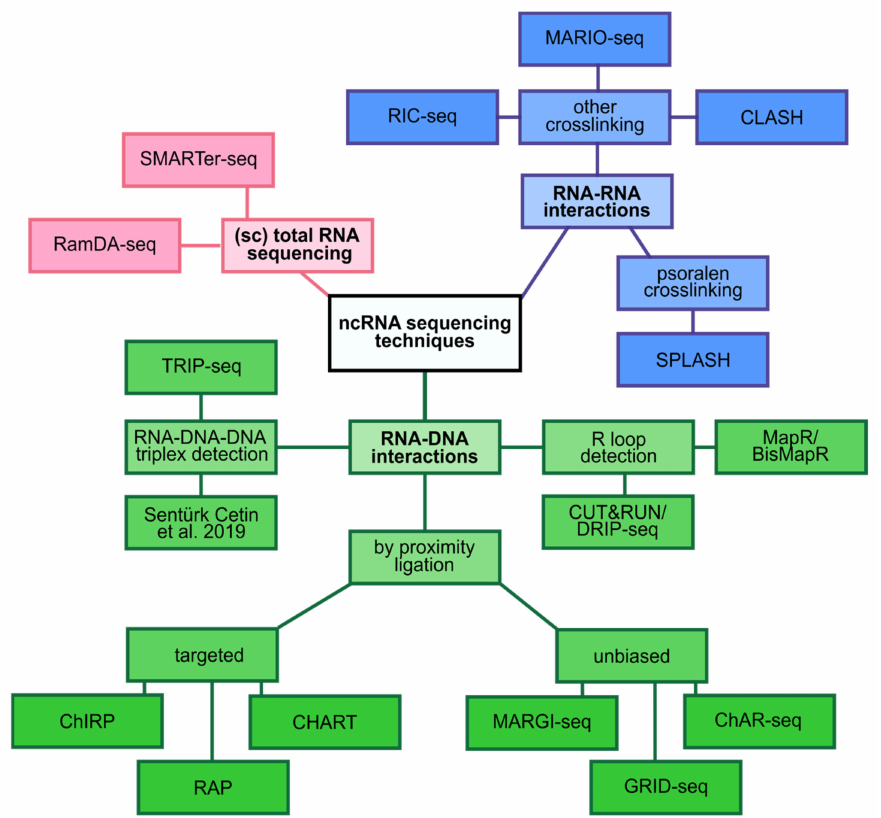
Figure 2. Overview of recent ncRNA sequencing techniques. The scheme summarizes techniques for single-cell total RNA sequencing (RamDA-seq [84], SMARTer-seq [86]), sequencing of RNAs interacting with DNA by proximity ligation (ChIRP [87], RAP [88], CHART [89], MARGI-seq [90], GRID-seq [91], ChAR-seq [92]), interacting in triplexes (TRIP-seq [93], Sentürk Cetin et al. [94]) and R loops (CUT&RUN [95], DRIP-seq [96], MapR [97], BisMapR [98]) as well as interacting with other RNAs (RIC-seq [99], MARIO-seq [100], CLASH [101], SPLASH